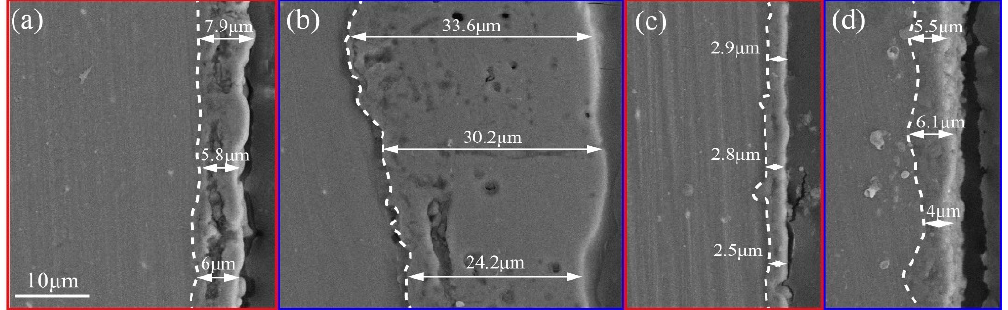
Figure 4. Cross-sectional morphologies of PEO-coated AZ31 magnesium alloy. ( a ) Al-coating, ( b ) Si-coating, ( c ) P-coating, ( d ) F-coating.